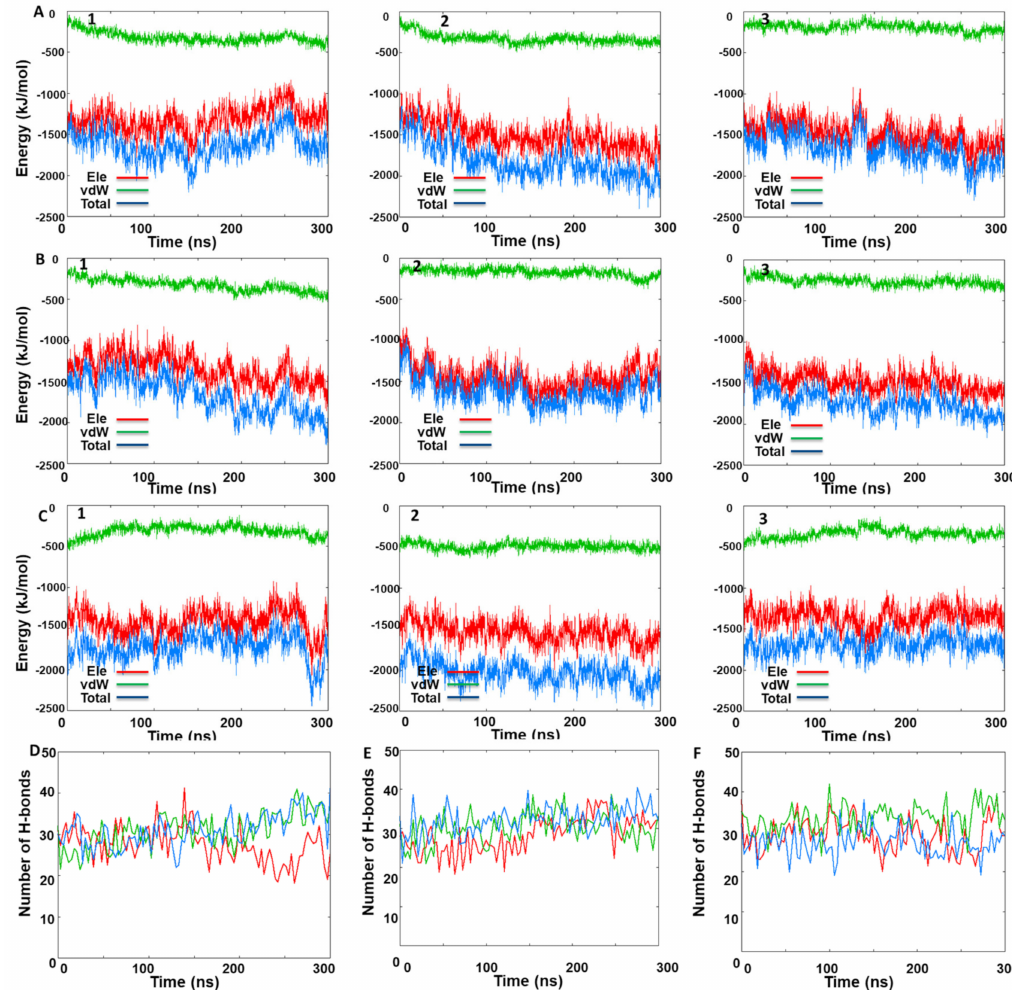
Figure 8. IRE1 back-to-back dimer MD simulation data for the three MD replicas. Time-dependent interaction energy profiles for monomer A with monomer B during the MD simulations of ( A ) native back-to-back dimer (PDB code: 4YZC), ( B ) KIRA docked in the 4YZC structure, and ( C ) protein–protein docked pose of PDB 4U6R in the back-to-back dimer. Hydrogen bond analysis between the monomers A and B during the three MD replicas for ( D ) native back-to-back crystal dimer (PDB code: 4YZC), ( E ) KIRA docked in PDB 4YZC structure, and ( F ) protein–protein docked pose of PDB 4U6R in the back-to-back dimer